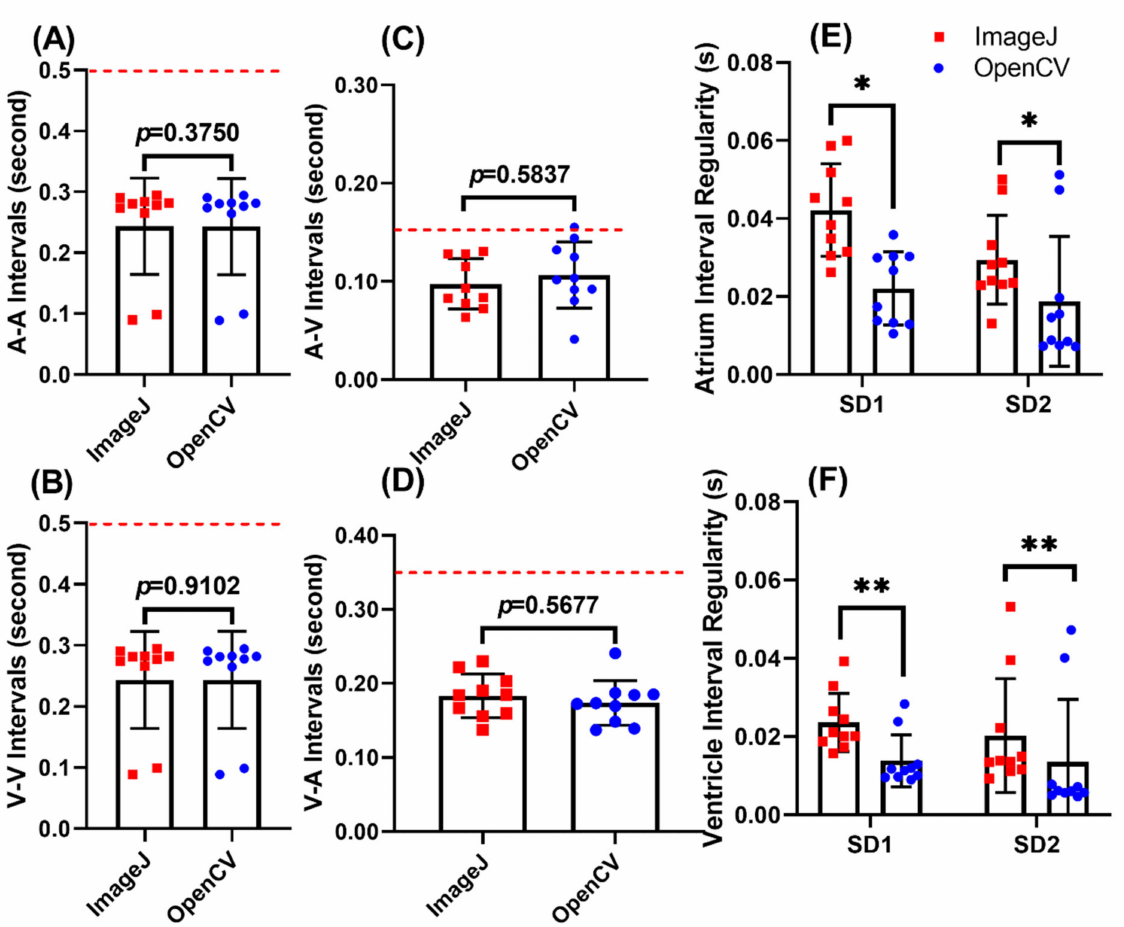
Figure 5. Comparison of heart rate regularity and cardiac rhythm measurement in IBMX treated zebrafish embryos aged at 72 hpf using either OpenCV (red color) or ImageJ (blue color) methods. Comparison of atrium to atrium (A-A) ( A ) and ventricle to ventricle (V-V) ( B ) intervals using either ImageJ or OpenCV methods. Comparison of atrium-ventricle (A-V) ( C ) and ventricle to atrium (V-A) ( D ) intervals using either ImageJ or OpenCV methods. Comparison of heartbeat regularity in either atrium ( E ) or ventricle ( F ) using either ImageJ or OpenCV methods, red dotted line signified the normal level of each parameter obtained from control group. Data was calculated using t -test ( A , B ) and Wilcoxon test ( C – F ), and presented as Mean ± SD, n = 10 (* p < 0.05; ** p <